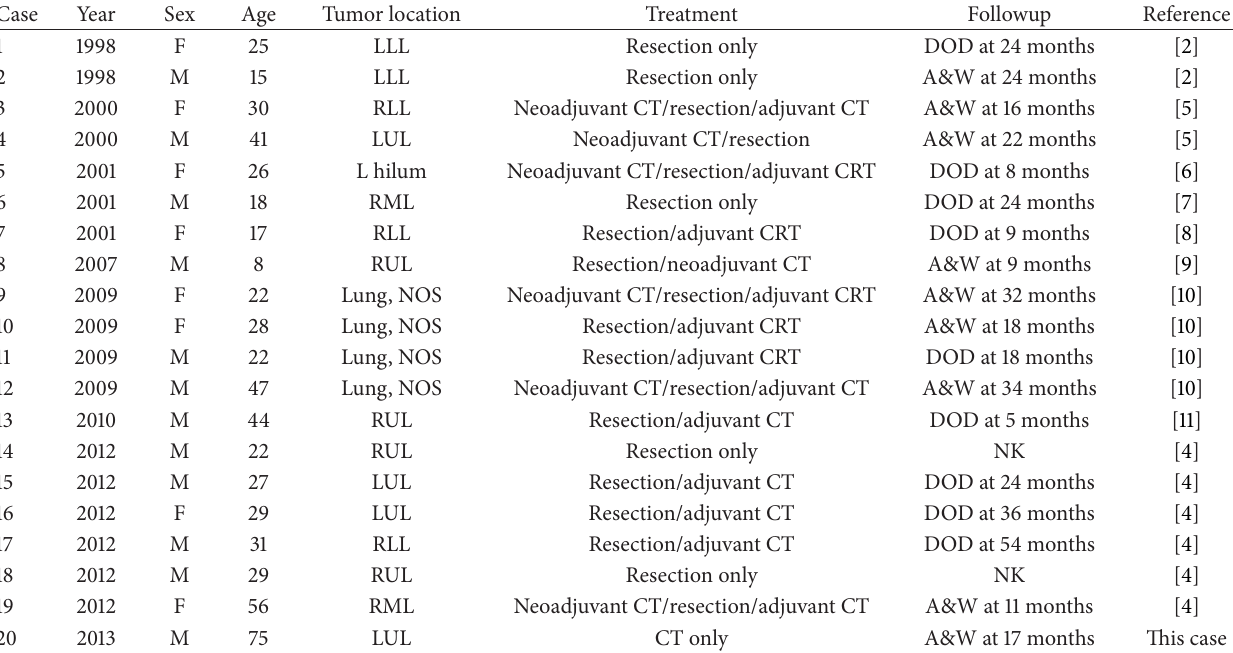
Figure 2: (a) Cytologic features, cellular aspirate PAP stained (original magnification, × 200).JPG; (b) Hematoxylin and Eosin stained cell block section shows a cluster of uniform cells with fine, pale chromatin and a moderate amount of cytoplasm (original magnification, × 200) 2.JPG; (c) CD99 EMA immunohistochemistry shows strong membranous staining (original magnification, × 400).JPG; (d) Periodic Acid Schiff (PAS) stain, × 200.JPG. Table 1: Primary pulmonary primitive neuroectodermal tumor patients in the